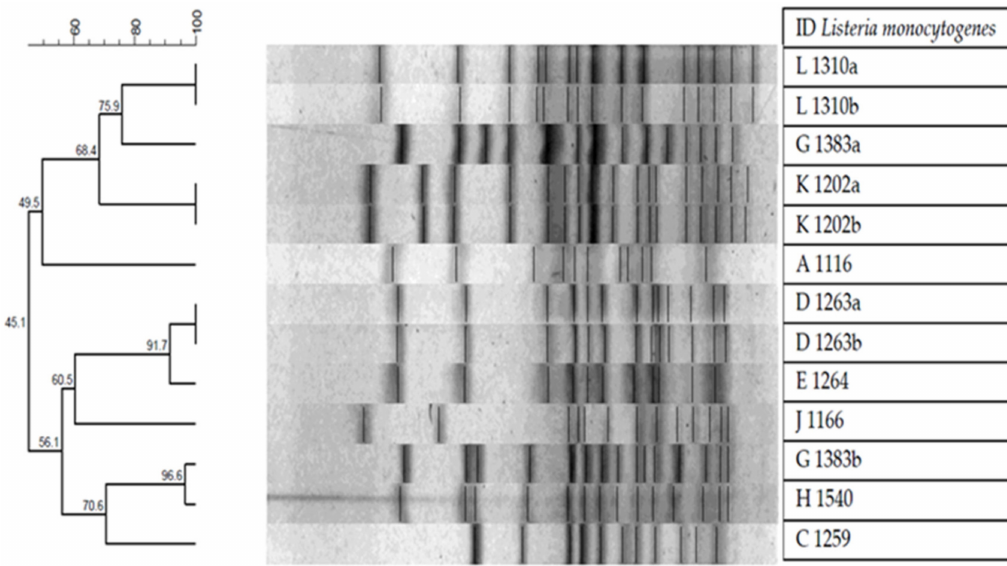
Figure 3. Pulsed-field gel electrophoresis (PFGE) of Listeria monocytogenes selected in the study. The test determined eight di ff erent groups of which four had more than two isolates. Strains 1202, 1263, and 1310 showed an identical pulsetype. Although from di ff erent food sources, strains 1310 and 1540 were very similar.